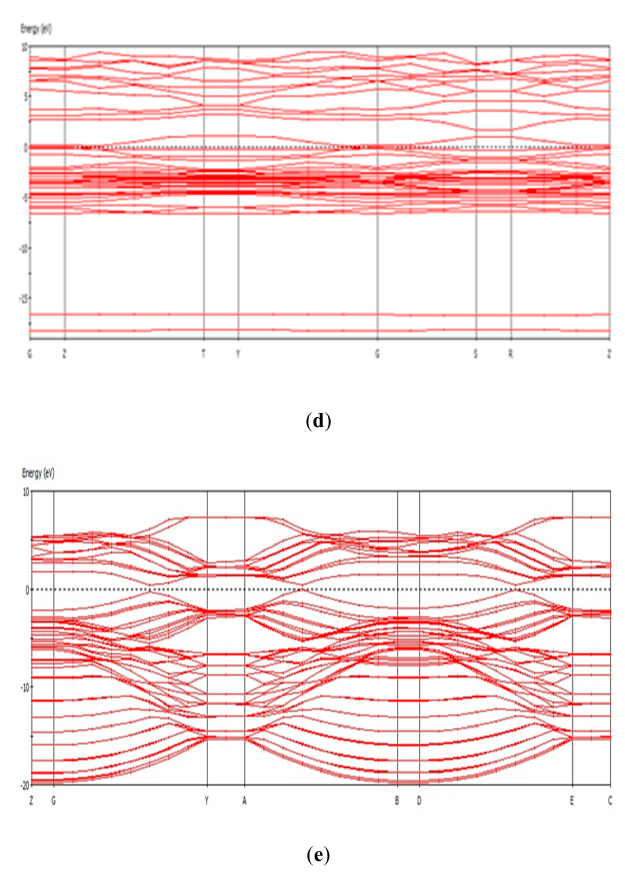
Figure 7. Wavelength changes over time during Fe 3 O 4 , Fe 2 O 3 , ZnO, Al 2 O 3 , and CNS injection.